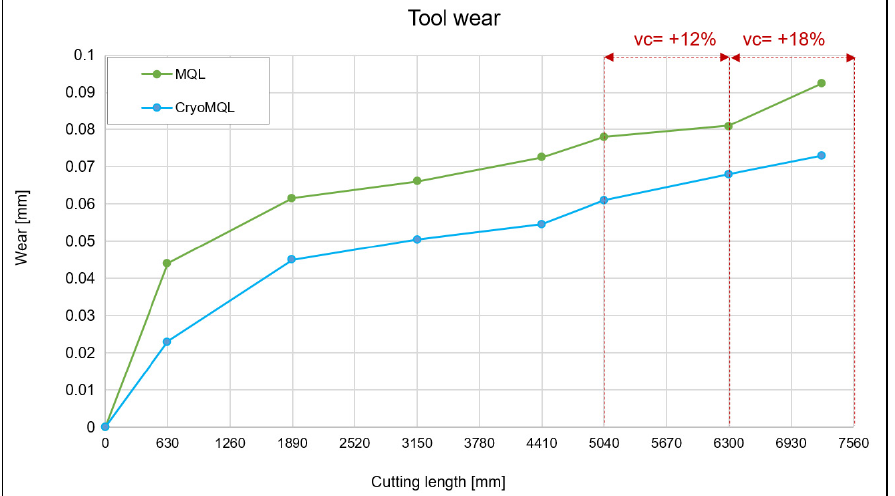
Figure 2. Tool wear due to cu tt ing length.